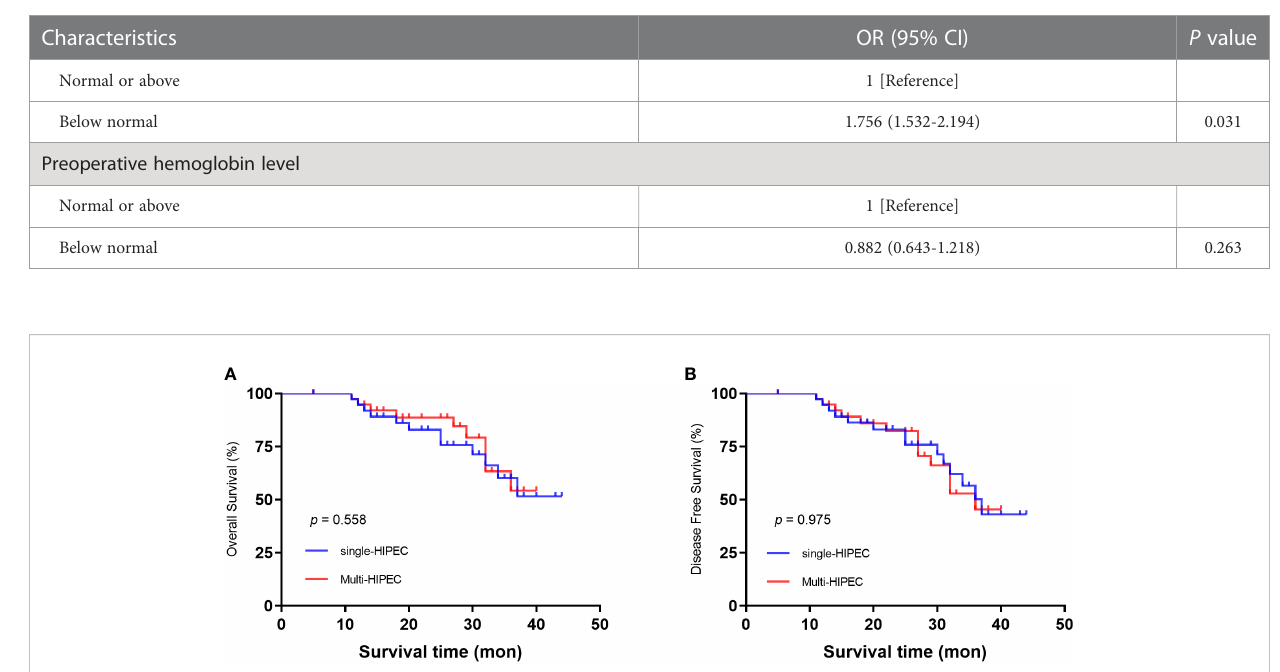
FIGURE 1 Kaplan ‒ Meier survival curves depicting the survival in patients with T4 gastric cancer. (A) Patient OS based on whether single or multi-HIPEC was performed. (B) Patient DFS based on whether single or multi-HIPEC was